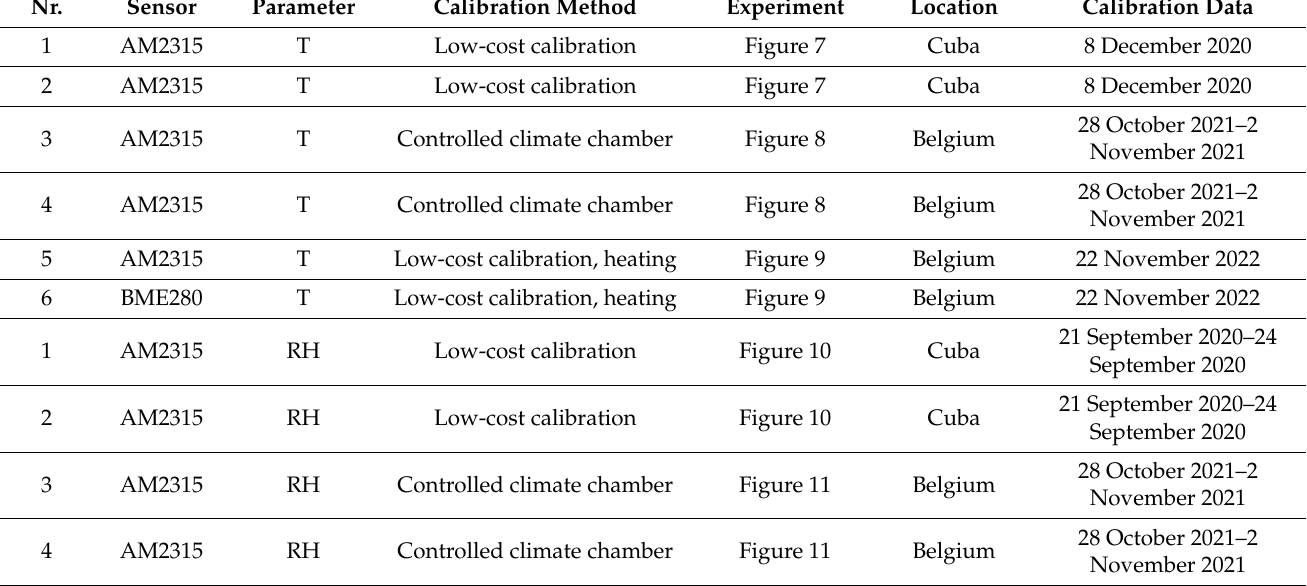
Table 1. Overview of the sensors and calibration experiments performed in this work. The sensor numbers (nr.) are used in Figures